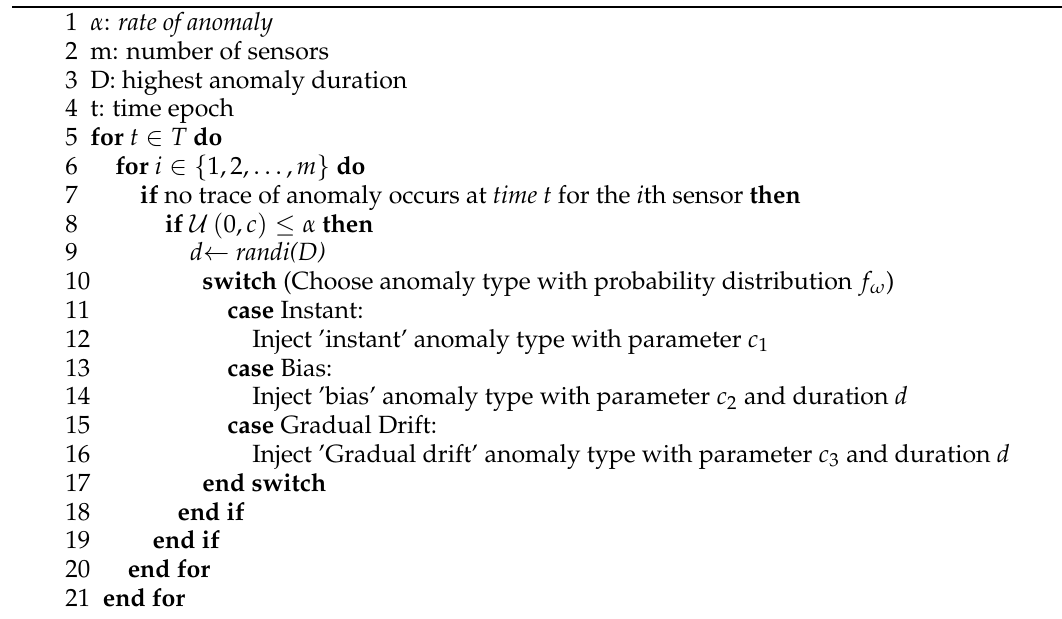
Algorithm 1: Connected and Automated Vehicles (CAV) Cyber Attack Generation